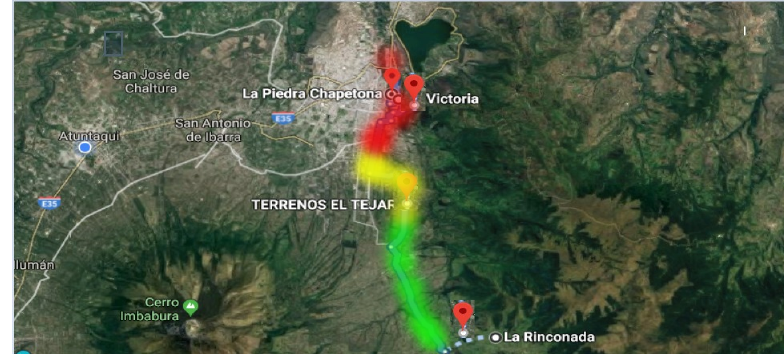
Figure 11. Tahuando river conditions along its stream bed.